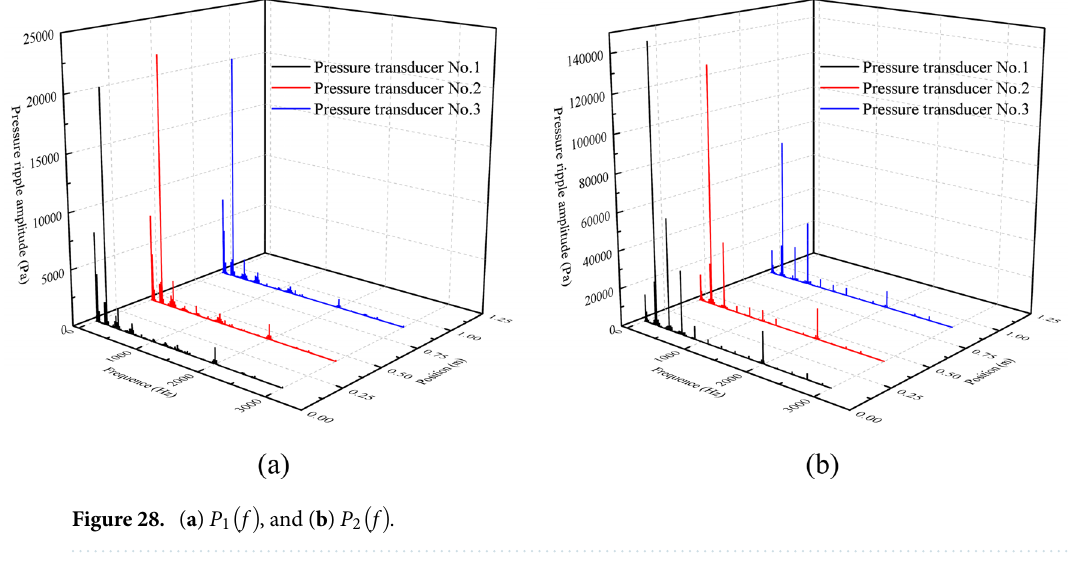
Figure 28. ( a ) P 1